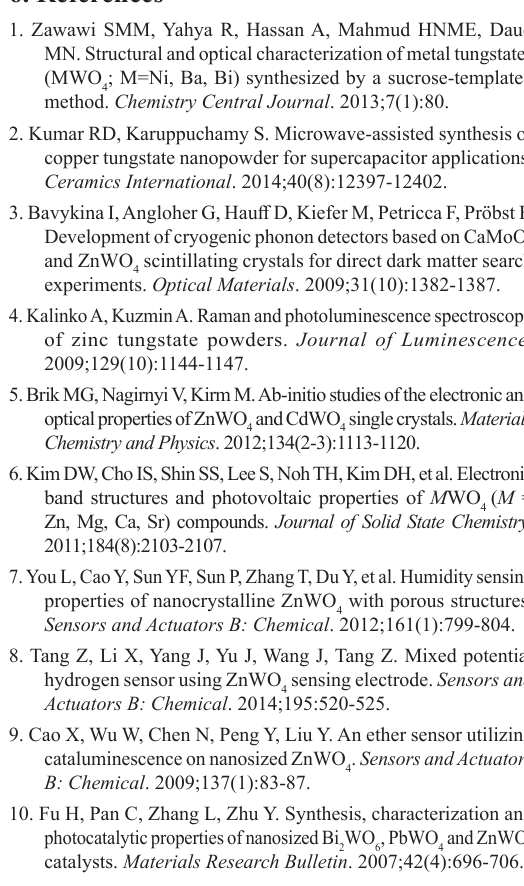
support, (b) immobilized 4 support and (c) free enzyme. 4